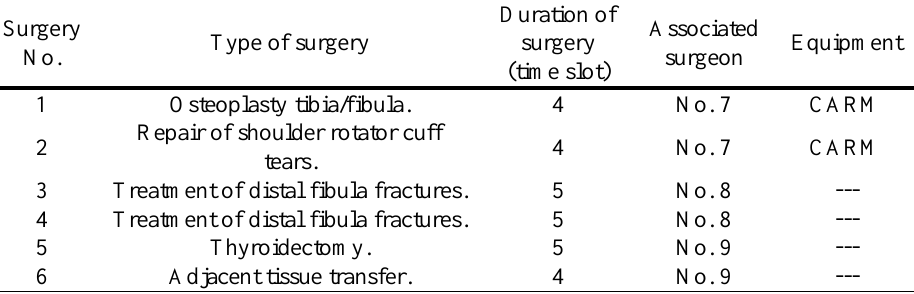
Table 1. List of surgeries, their associated surgeons, and required